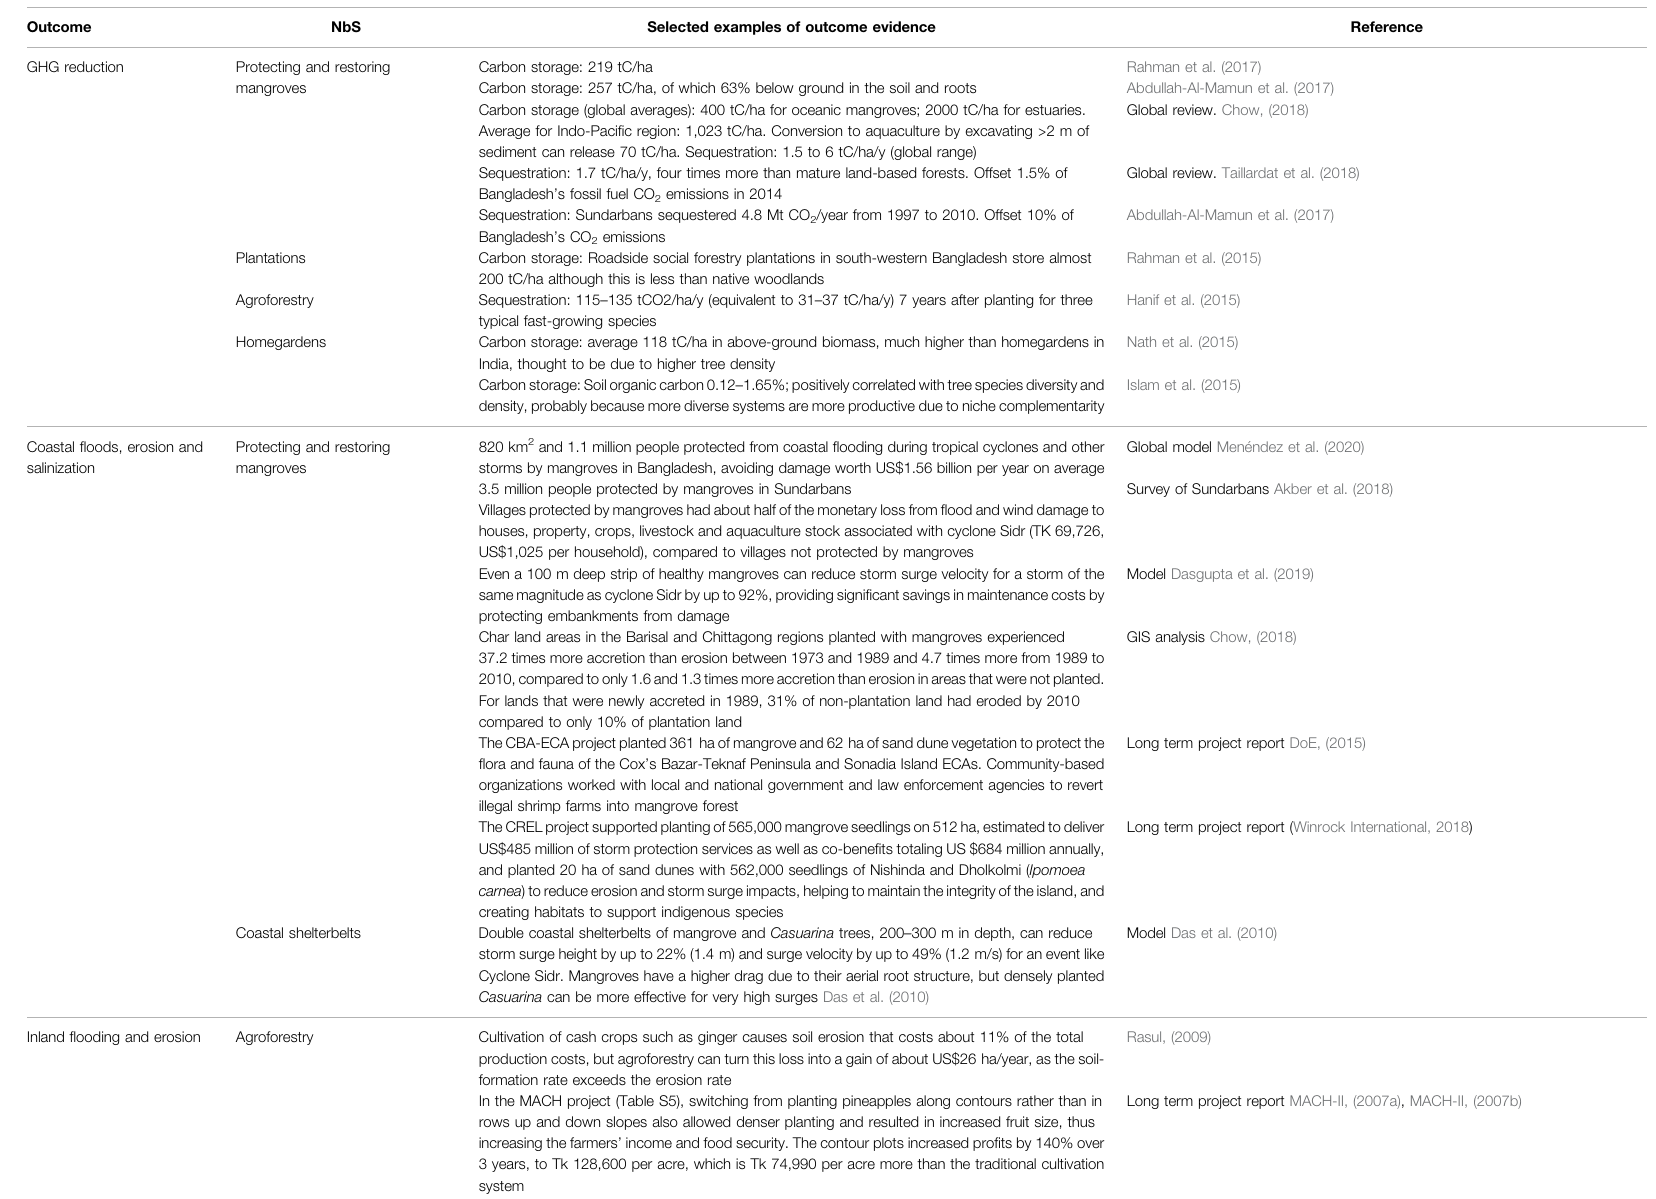
TABLE 5 | Key examples of evidence on the target outcomes of NbS cited in Effectiveness of Nature-based Solutions for Addressing the Target Outcomes